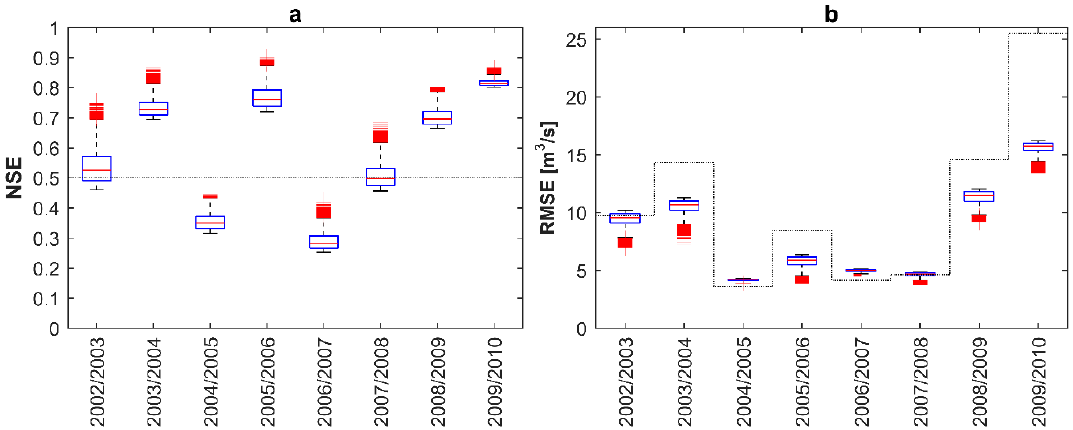
Figure 3. NSE ( a ) and RMSE ( b ) statistical metrics corresponding to model simulations yielding Nash Sutcliff Efficiencies (NSEs) above the 99.5th percentile of the NSE values obtained during calibration. Each box shows minimum (bottom whisker), 25th percentile (bottom edge of the box), 50th percentile (red line inside the box), 75th percentile (top edge of the box), maximum (top whisker), and extreme values (red plus markers). The dashed lines correspond to the 0.5 NSE acceptance threshold ( a ) and the values of 30% less than the observed streamflow standard deviation ( b) .